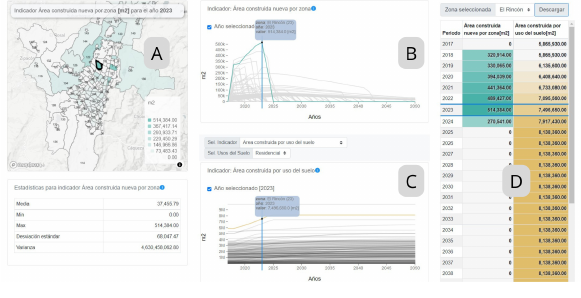
Figure 1. Intra-zone explorer tool